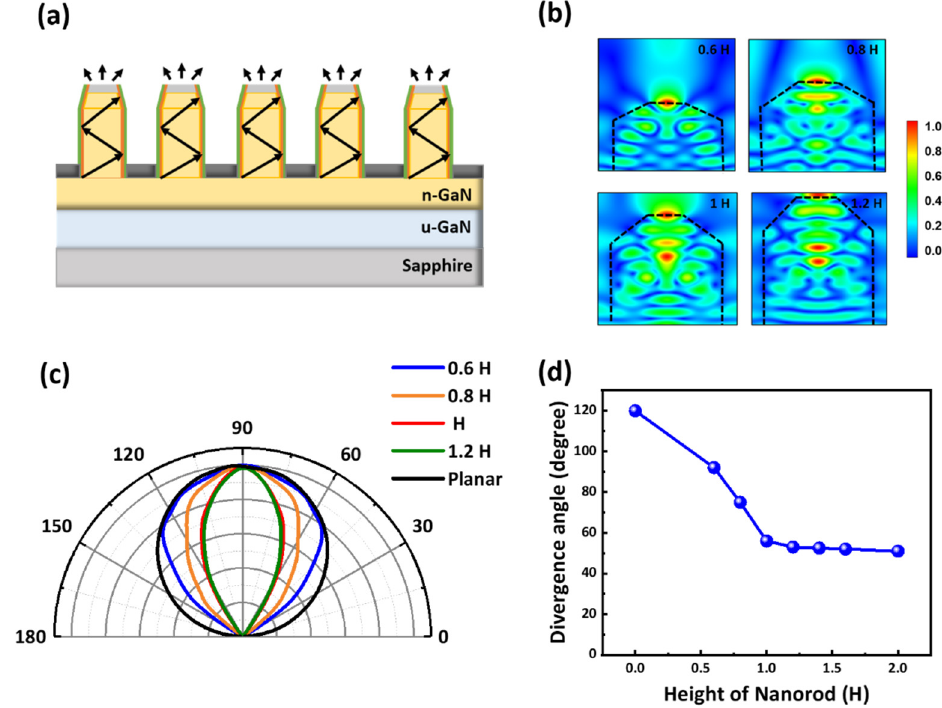
Figure 4. ( a ) FDTD simulation of light confinement by core–shell nanorod structure; ( b ) simulation results of the light confinement effect by the nanorod structure at different heights (H = 980 nm); ( c ) light field pattern; ( d ) calculated divergence angle.